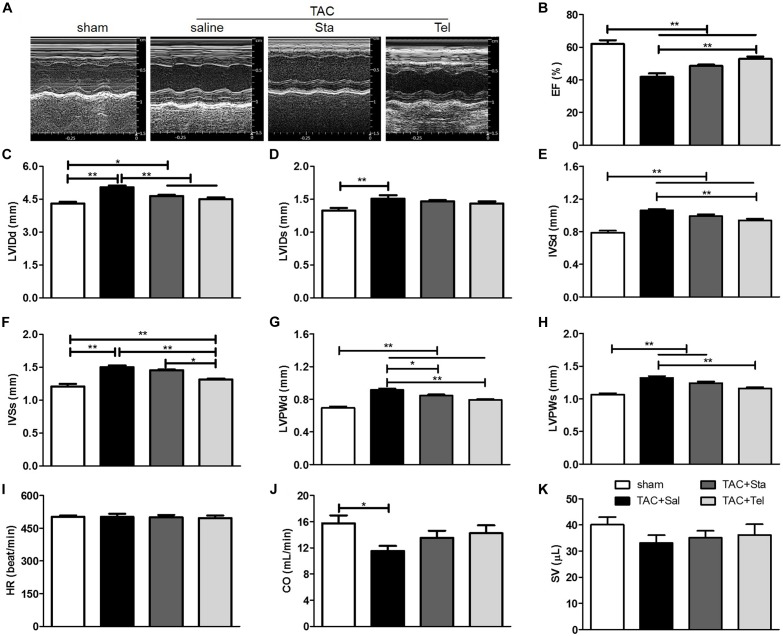
Sta attenuated pressure overload induced cardiac functional remodeling. (A) Representative M-mode tracings of echocardiography after 4 weeks of surgery. (B–K) Quantification echocardiographic parameters: (B) Left ventricular ejection fractions (EF); (C) left-ventricular internal dimension at diastole (LVIDd); (D) left-ventricular internal dimension at systole (LVIDds); (E) interventricular septal wall thickness at diastole (IVSd); (F) interventricular septal wall thickness at systole; (G) left ventricular posterior wall thickness at diastole (LVPWd); (H) left ventricular posterior wall thickness at systole (LVPWs); (I) heart rate (HR); (J) cardiac output (CO); (K) stroke volume (SV). The data were expressed as the mean ± SEM. ∗∗P < 0.01; ∗P < 0.05; n = 6–8 in each group; TAC, transverse aortic constriction; Sal, saline; Sta, stachydrine; Tel, telmisartan.